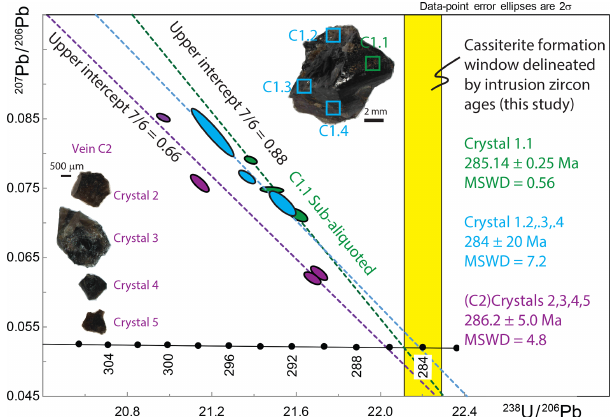
Figure 8. T–W plot and regression lines for HF-leached cassiterite from Cligga Head relative to possible age defined by zircon (Fig. 6). Regressions are for the following: C1.1 sub-aliquots ( n = 4) as pre- sented in Fig. 7; spatially independent samples of the same crystal ( n = 3); and independent crystals from a different vein (C2) ( n = 4). Note that the y intercept value is for regression anchored to the max- imum possible lower intercept as defined by the granite; it therefore represents a maximum y -intercept value. Only the sub-aliquots of C1.1 yield a regression without over-dispersion. See the text for fur- ther